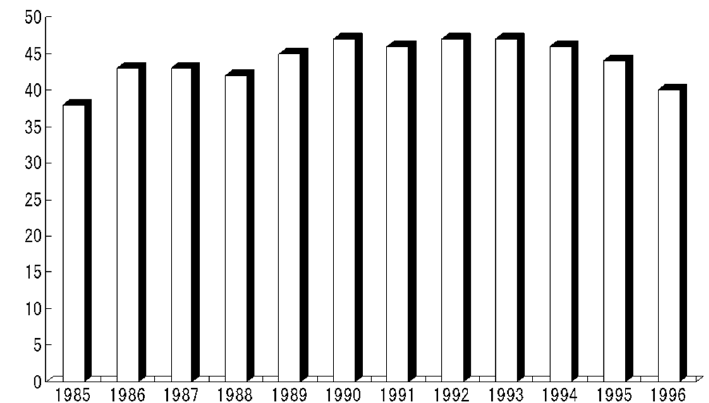
Figure 3. The change in the share of the reciprocal contracts. Source: the author of this paper was personally provided by the company with these statistics.